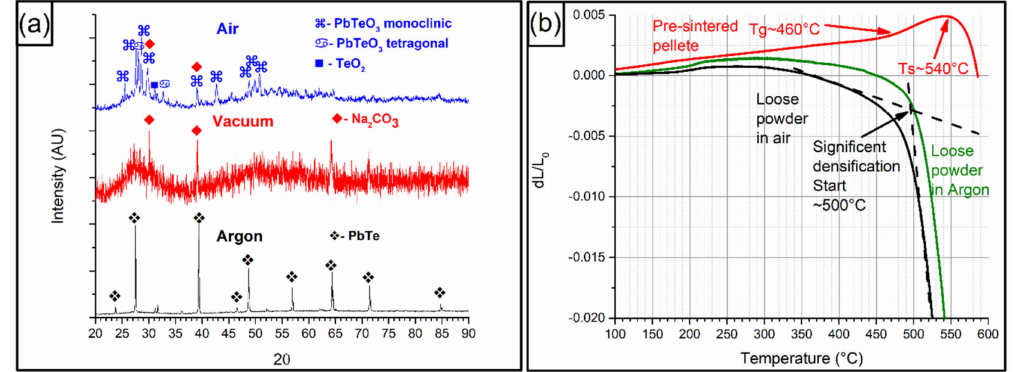
Figure 2. ( a ) XRD patterns of the coated samples, following 520 ◦ C / 30 min. thermal treatment under argon (black), vacuum (red) and air (blue) atmospheres. ( b ) Dilatometry measuremnts of the glass powder in air (black) and argon (green) with a pre-sintered pellete (red) as reference, showing densification at lower temperatures in air and that densification is expected at a little above 500 ◦